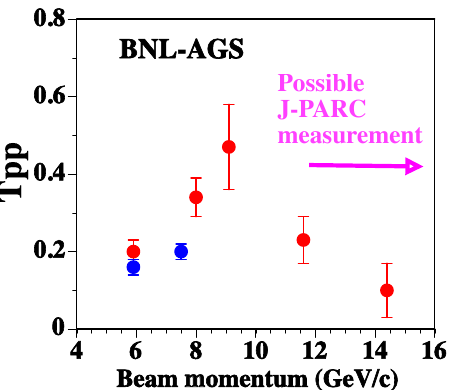
Figure 4. Nuclear transparency, T pp , in pA → 2 p ( A − 1 ) reactions by BNL-AVA experiment [7].